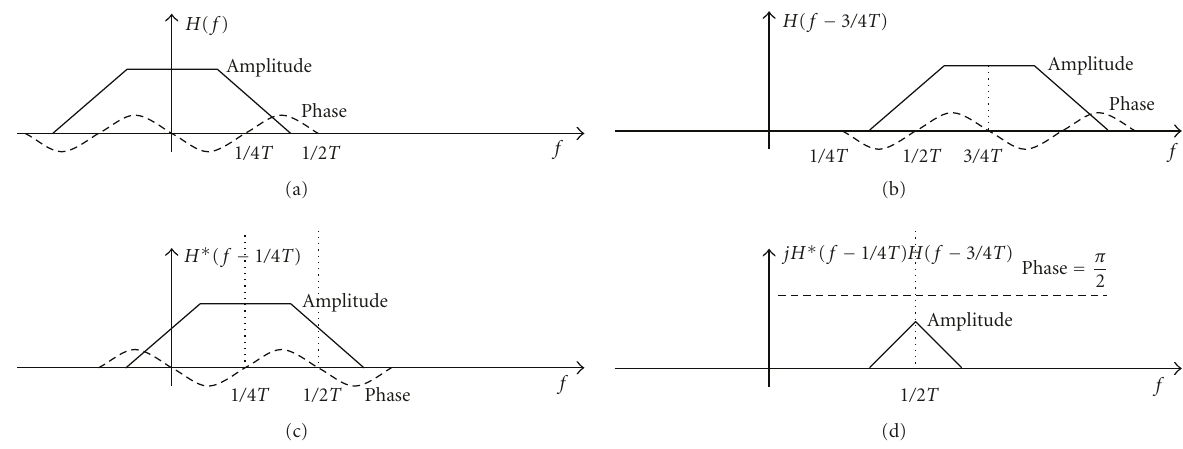
Figure 5: Demonstration of ICI cancellation in CMT when H ( f ) has a relaxed phase